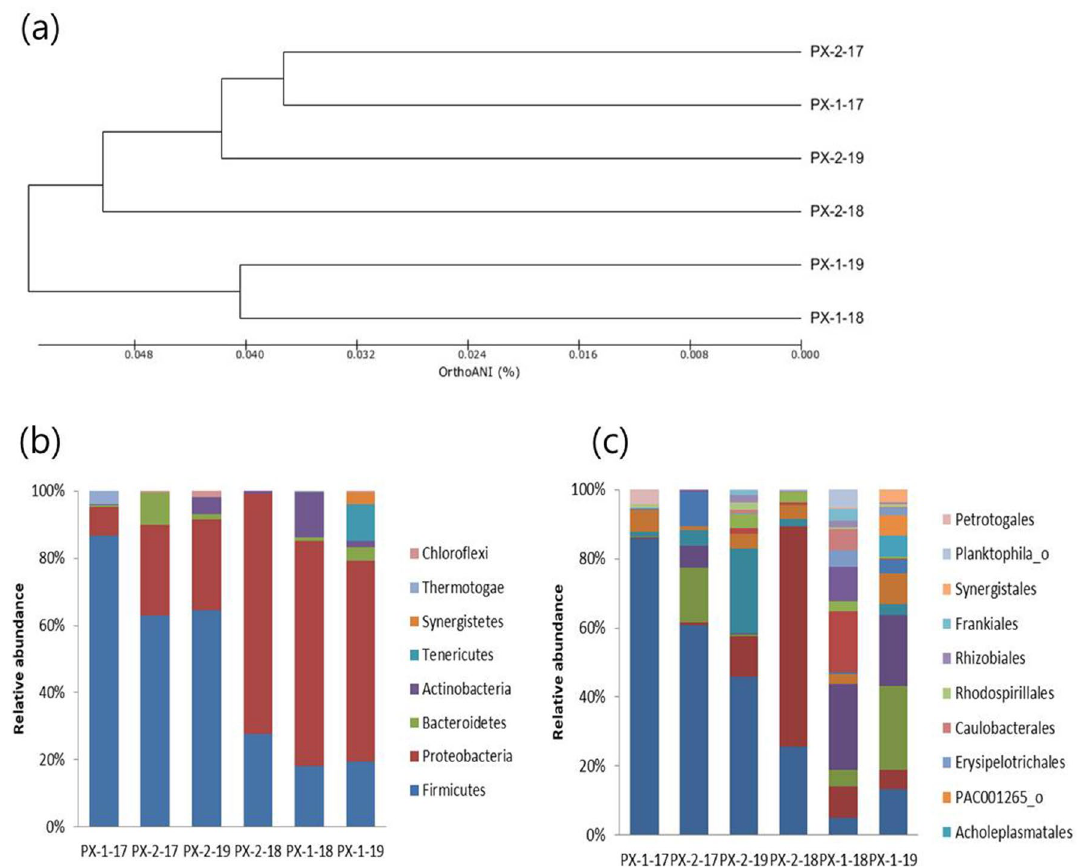
Figure 7. ( a ) Hierarchical clustering of bacterial communities in PX-1 and PX-2 sampled after the M W 3.2 (PX- 1–17 and PX-2–17) earthquake, M W 5.5 earthquake in August 2018 (PX-1–18 and PX-2–18), and in April 2019 (PX-1–19 and PX-2–19). Relative sequence abundances of bacteria taxa in PX-1 and PX-2 at the ( b ) phylum and ( c ) order